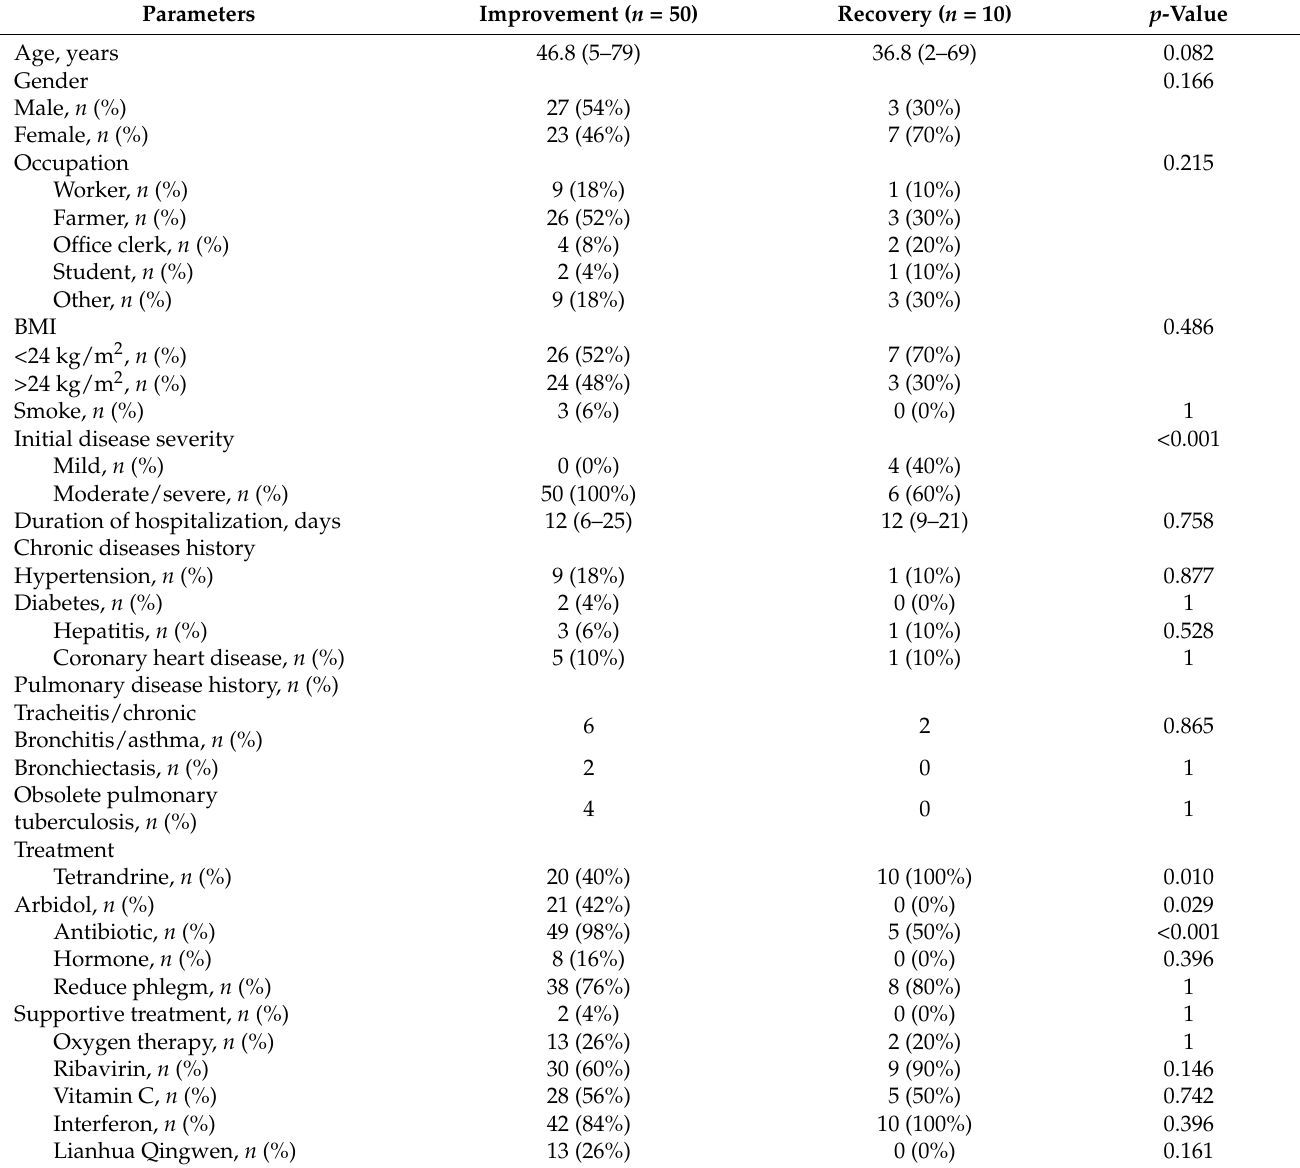
Table 1. Demographic and clinical characteristics and treatment comparisons between different outcomes.